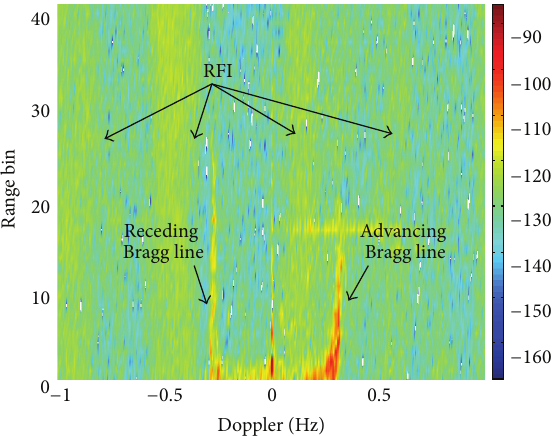
Figure 4: RD plot after direct-path wave rejection.